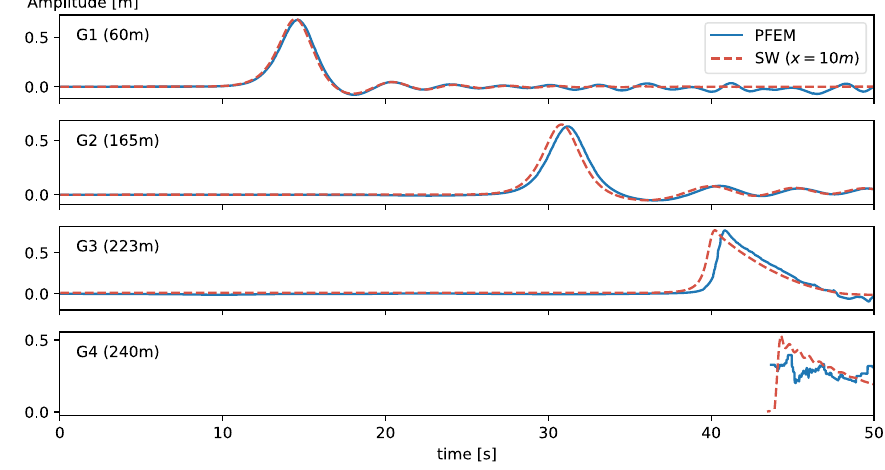
Fig. 6 Solitary wave example. Time series obtained with the interface at x = 10 m